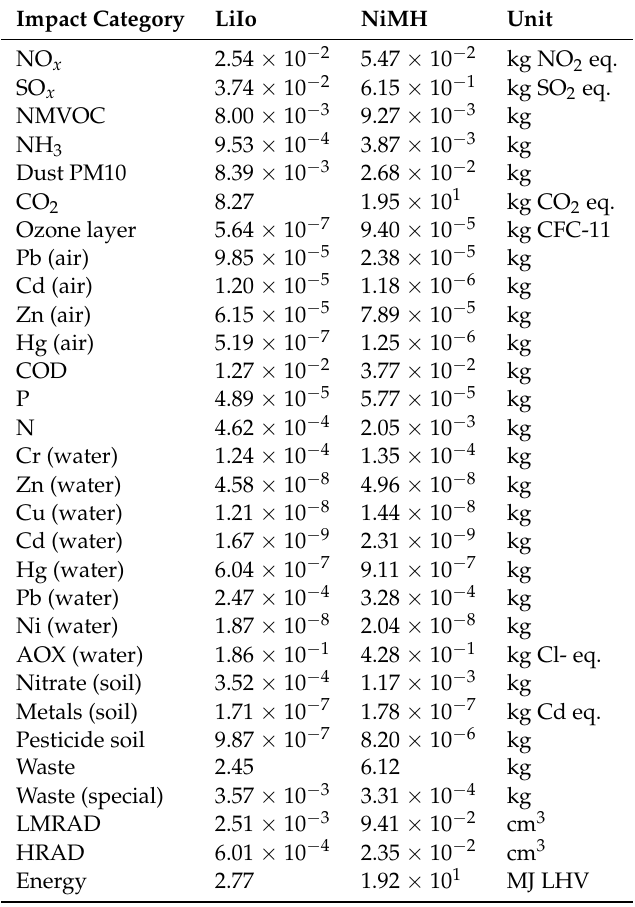
Figure 11. Comparison of metal and gas-based emissions of LiIo and NiMH batteries by the EcoPoints 97 method. Table 6. Comparative effects of LiIo and NiMH batteries by EcoPoints 97